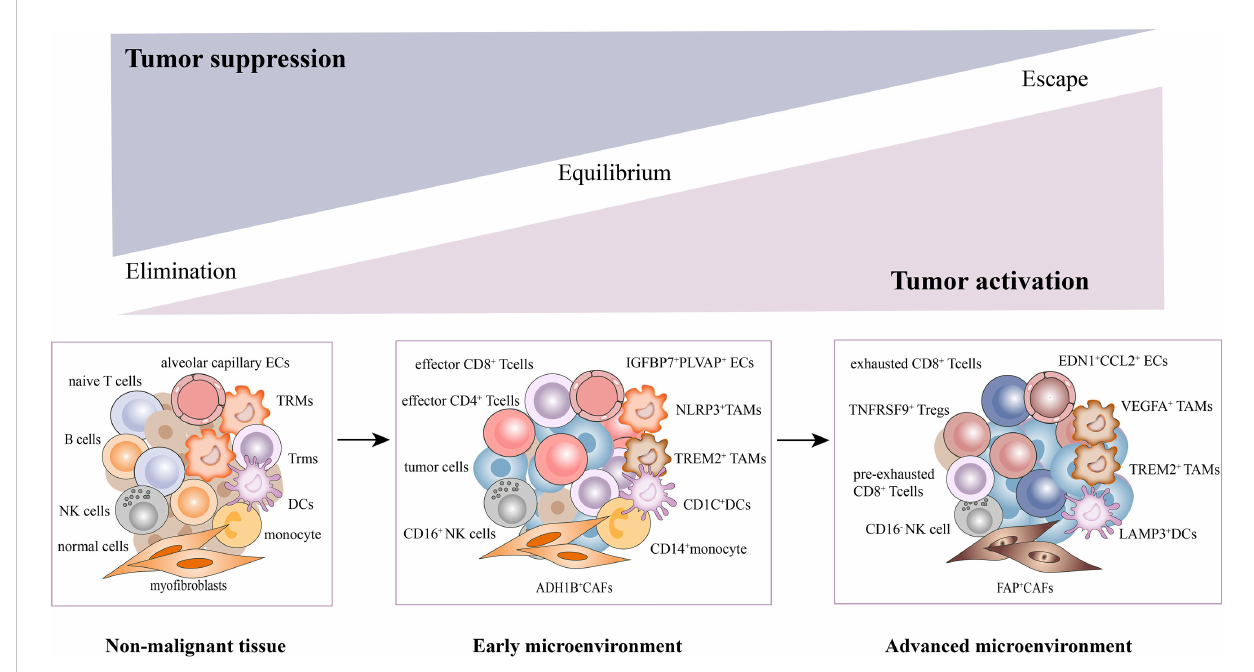
FIGURE 2 Dynamic changes of stromal subsets during tumor progression in the TME. The stromal cells undergo phenotypic remodeling and functional state shifts that drive the microenvironment toward immunosuppression, along with tumor cells. With the tumor progression, T cells underwent a gradual exhaustion process. The CD4 + /CD8 + effector T cells, CD16 + NK, NLRP3 + TAMs, ADH1B + CAFs, CD1C + DCs, and EDN1 + CCL2 + ECs were mainly enriched in early tumors. While pre-exhausted, exhausted T cells, TNFRSF9 + Tregs, CD16 - NK, VEGFA + TAMs, FAP + CAFs (activated CAFs), LAMP3 + DCs and IGFBP7 + PLVAP + ECs were mainly found in advanced